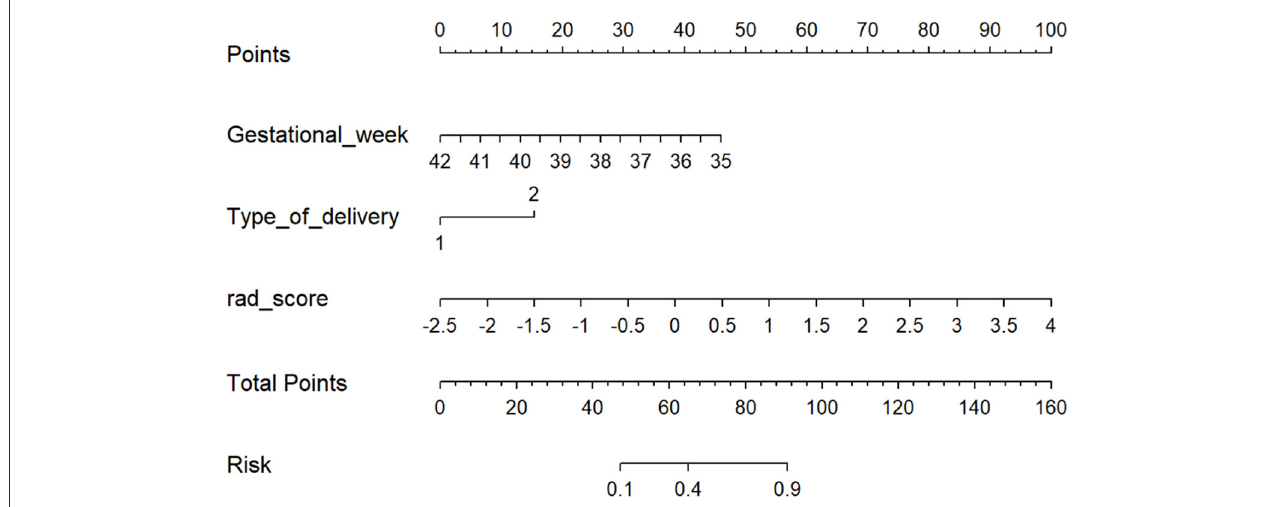
FIGURE3 The nomogram based on the clinical-radiomics model. Including gestational week, type of delivery, and rad-score. For each neonate, the total points were calculated by adding up the points of each variable and translated into the risk of ABE. Type of delivery 1 represents spontaneous labor and 2 represents cesarean delivery.